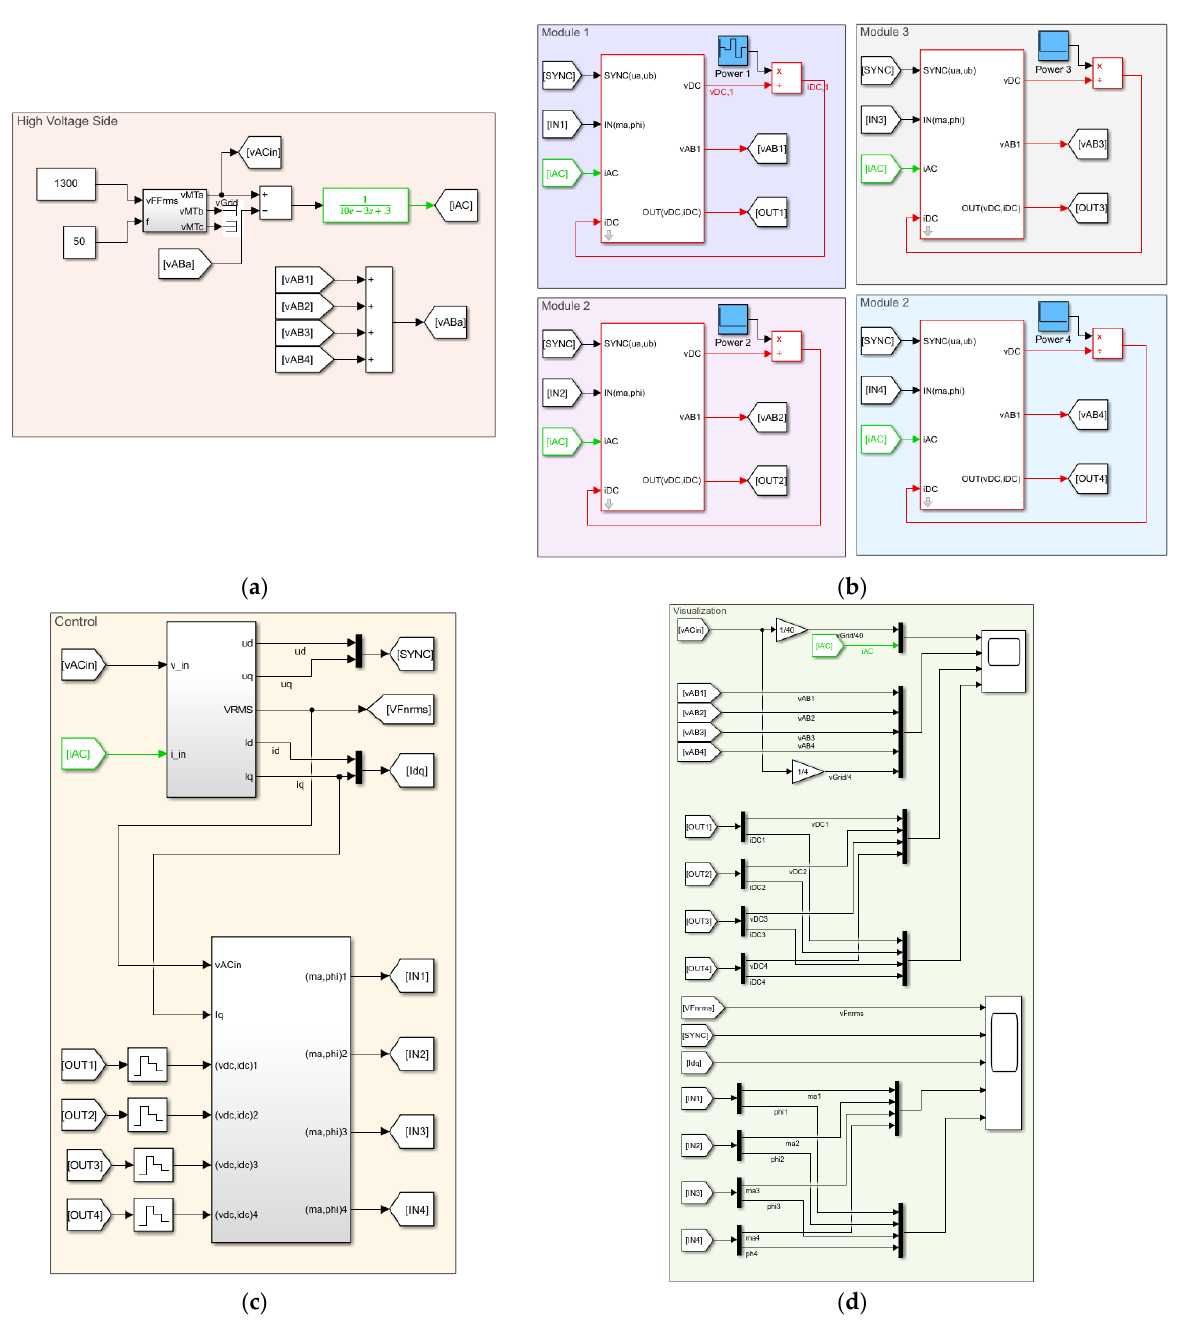
Figure 7. Overall high-level scheme in MATLAB/Simulink of the simulated MPST composed of four PEB s: ( a ) grid model and series connection of PEB HV terminals, ( b ) PEB models, ( c ) control strategy block and ( d ) visualization